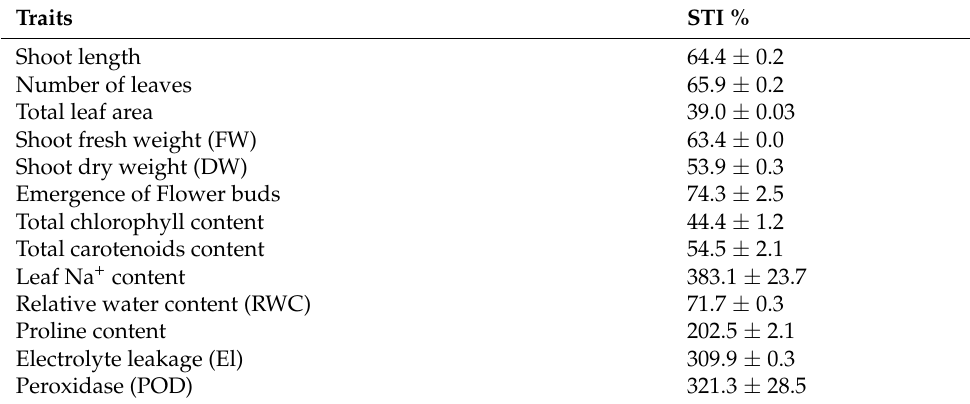
Figure 1. The effects of exogenous melatonin application (0, 50, 100, and 200 µ M) on Na + level ( A ), RWC ( B ), chlorophyll ( C ), and carotenoids content ( D ) of R. asiaticus under saline conditions. Control: no-stress and no melatonin; S1: plants under salt stress EC 4.5 dS · m − 1 ; S2: plants under salt stress EC 5.5 dS · m − 1 ; different letters are for significantly different groups (Tukey/Dunnett p < 0.05). The lowercase letters are for significant differences amongst melatonin concentrations under fixed salinity treatments, and the uppercase letters for significant differences in the salinity treatments with the control group under fixed melatonin concentration levels ( n ≥ 5). Table 2. Salt tolerance index (STI)% of R. asiaticus